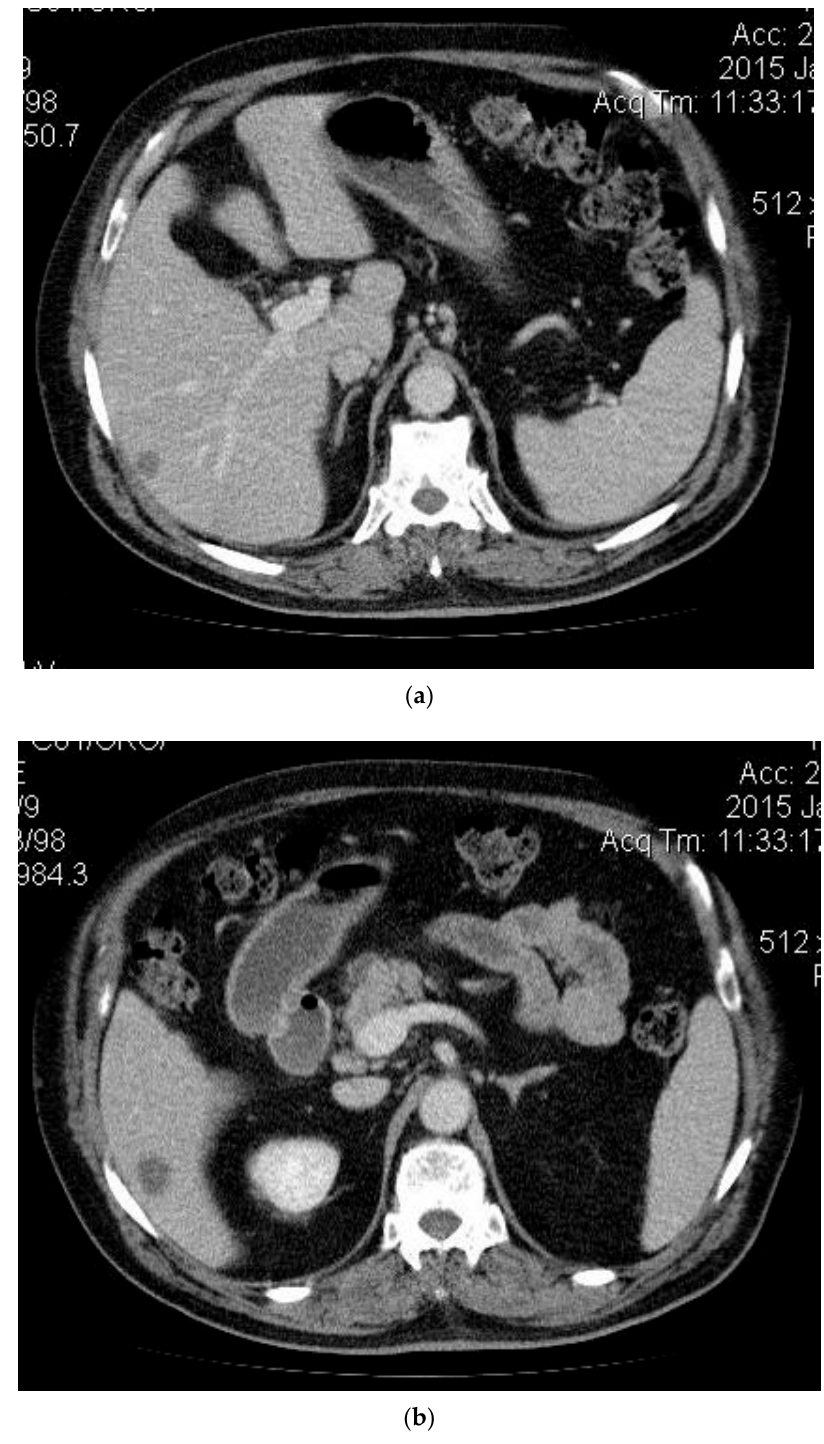
Figure 2. Preprocedure CT. ( a ) Metastatic lesion mass-1; ( b ) Metastatic lesion mass-2.